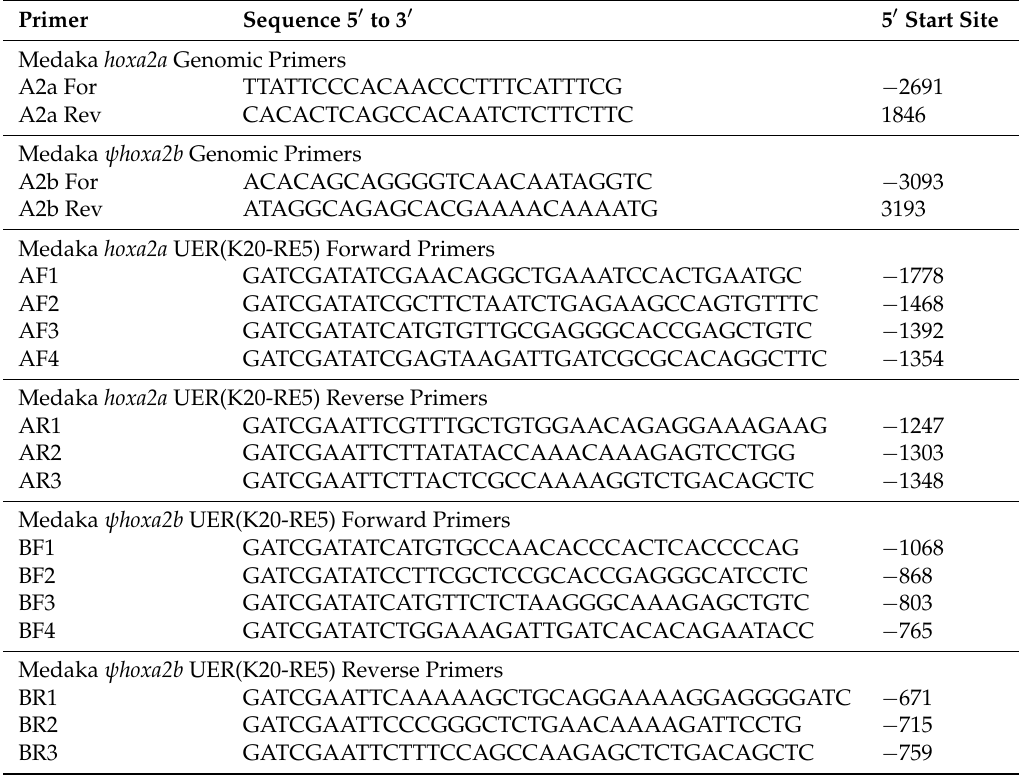
Table 1. Primers used for the amplification of the medaka hoxa2a and ψ hoxa2b UER(K20-RE5)s and the exclusion of sequence elements for the functional testing of these regulatory regions. The 5 1 -start site for primers pertains to the nucleotide base position with respect to the ATG start site of the downstream gene ( hoxa2a ) or pseudogene ( ψ hoxa2b